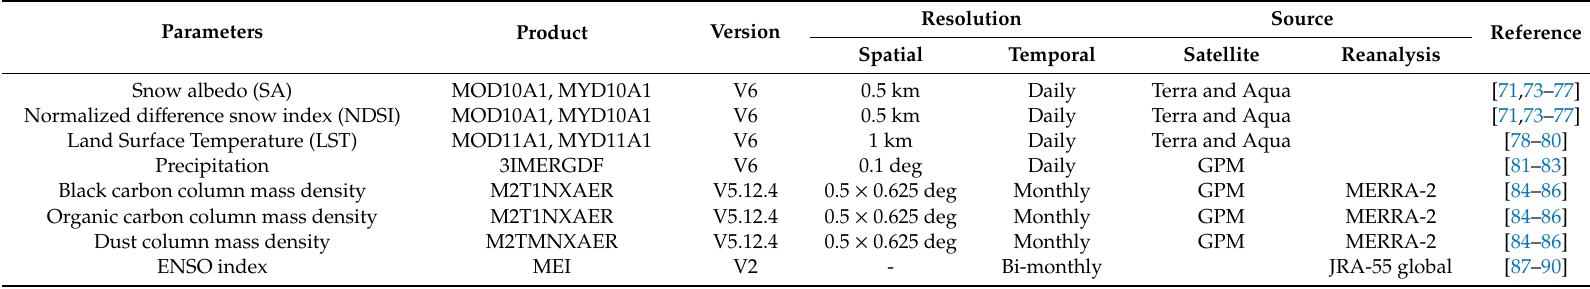
Table 1. Data set used in this research. Reference column indicates the sources of literature used to consider that each product is adequate and corresponds to validations or use in previous